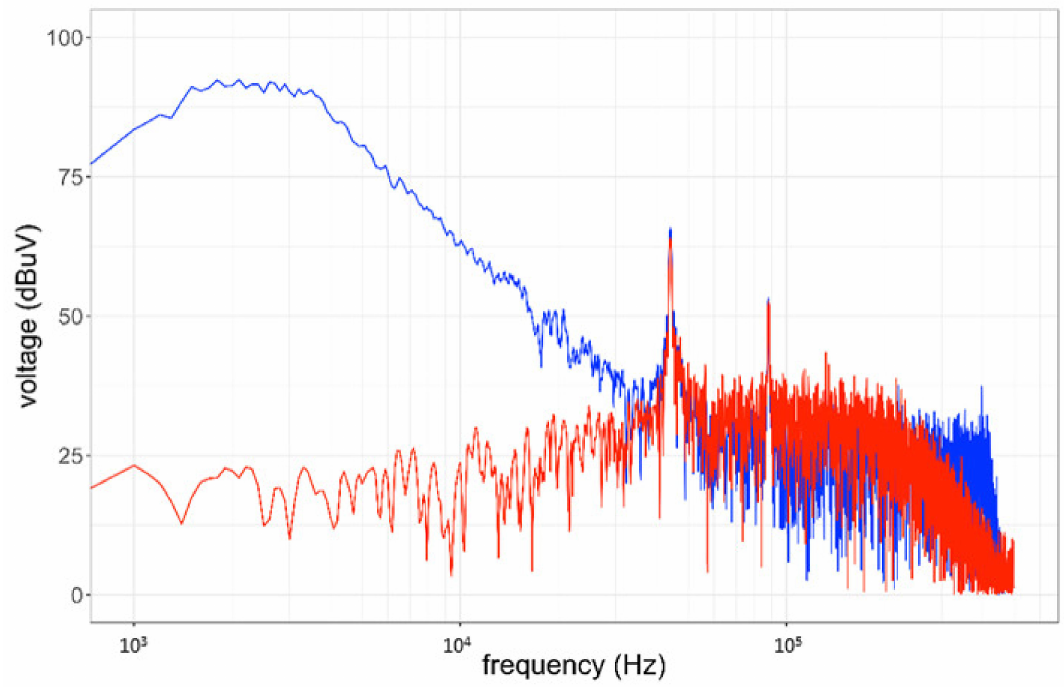
Figure 13. Comparison of the FFT spectra obtained from IMFs 2–4 extracted with EEMD ( red ) and from the original signal ( blue